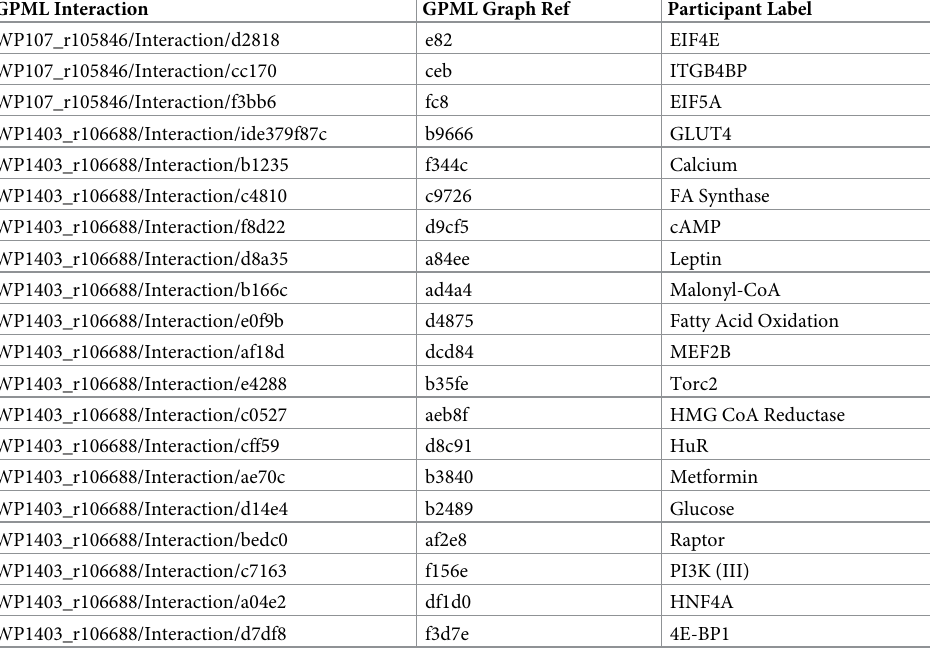
Table 7. Curation query showing interaction, GPML graph ref from the WikiPathways RDF, and label for node at end of interaction. GPML Interaction